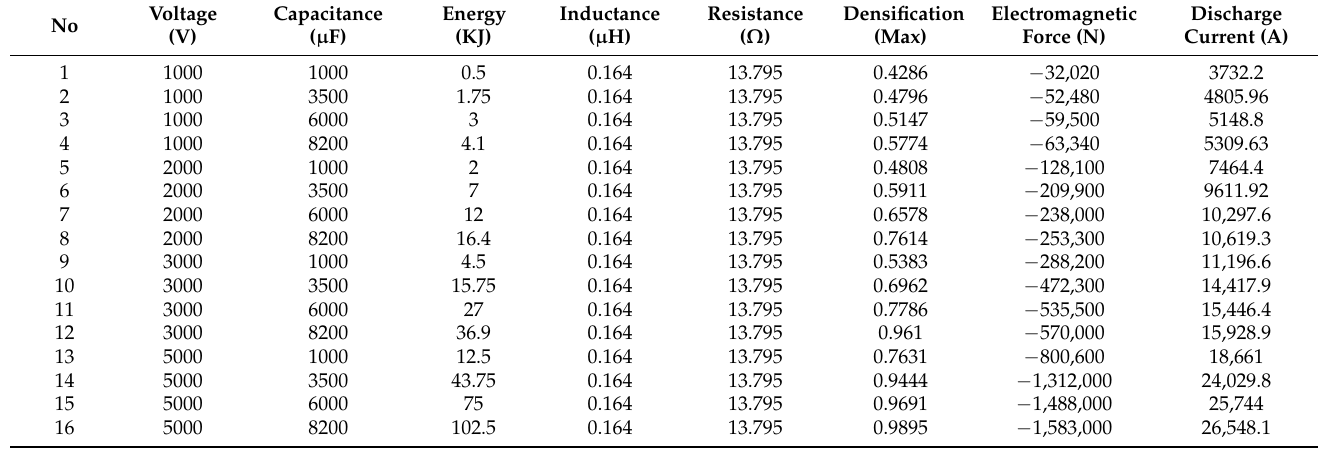
Table 4. Experimental plan and results.